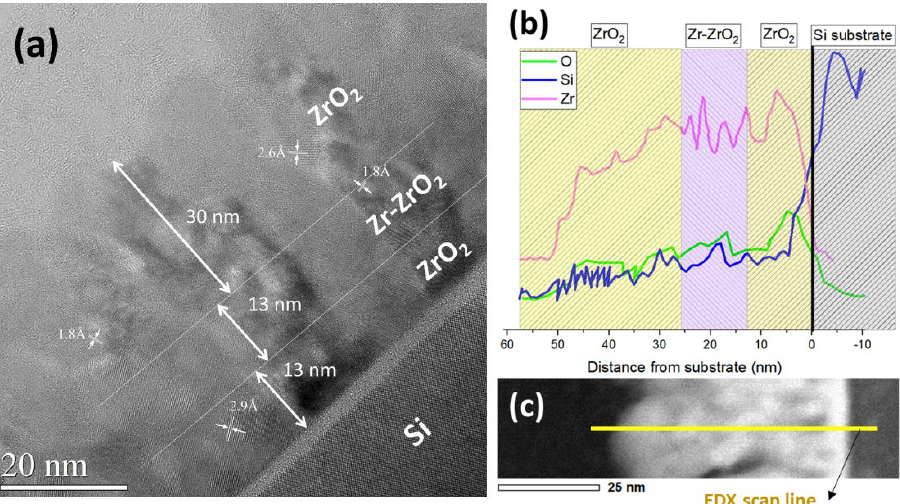
Figure 1. ( a ) HRTEM image obtained of the Zr10-700 structure; ( b ) EDX analysis with relative concentrations of Zr (magenta), Si (blue), and O (green), measured on the cross-section of the sample; ( c ) High-angle annular dark-field (HAADF) cross-section image.